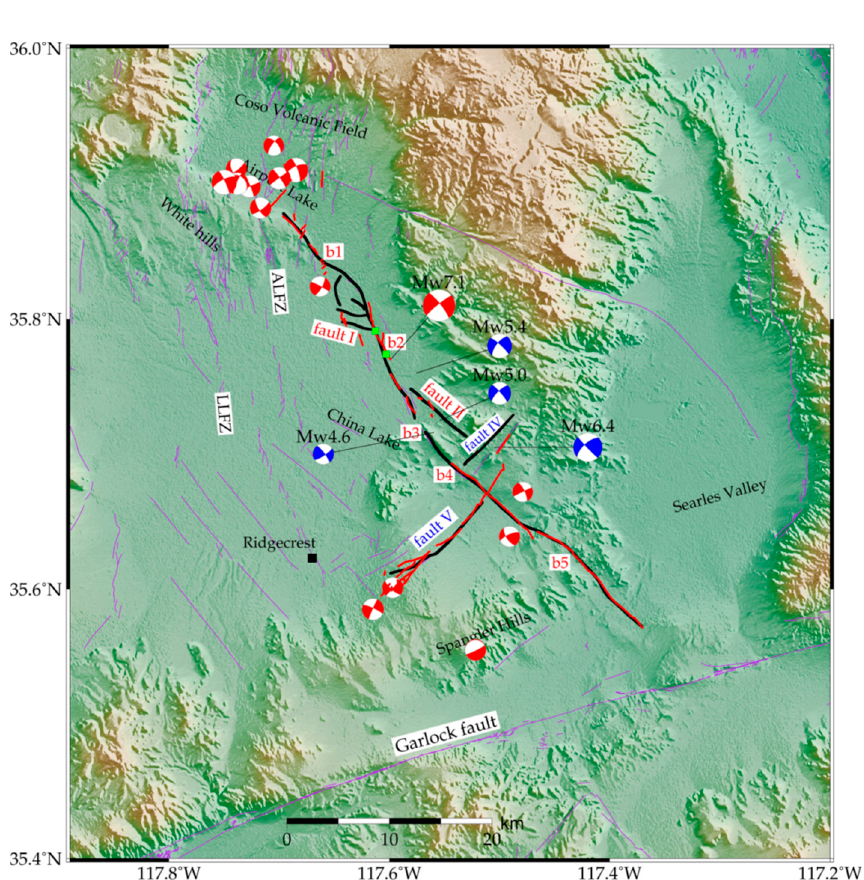
Figure 8. The surface rupture traces of the 2019 Ridgecrest earthquake sequence. Purple lines indicate the faults recorded in the U.S. Geological Survey (USGS) Quaternary Fault database (U.S. Geological Survey and California Survey, 2010) and in the 2010 Fault Activity Map of California (California Geologic Survey, 2010). Black lines indicate the surface rupture traces of the main fault and some secondary faults identified from displacement field and curl. Blue beach balls show the focal mechanisms of the large foreshock (from USGS). Red lines indicate the surface rupture traces produced by the mainshock obtained by field investigations. Green rectangles indicate the regions with the horizontal slip ~4.2 ± 0.5 m and vertical separation ~3.7 ± 0.2 m reported by the University Consortium for Satellite Navigation Systems and Crustal Deformation Observations